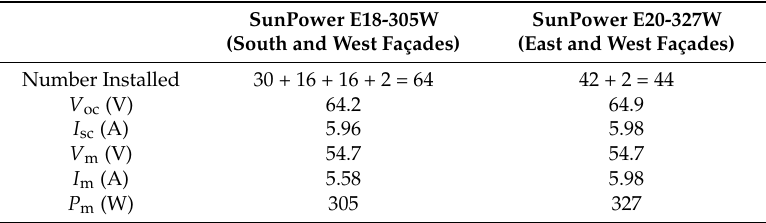
Table 1. Main electrical specifications of the two types of PV modules used in the